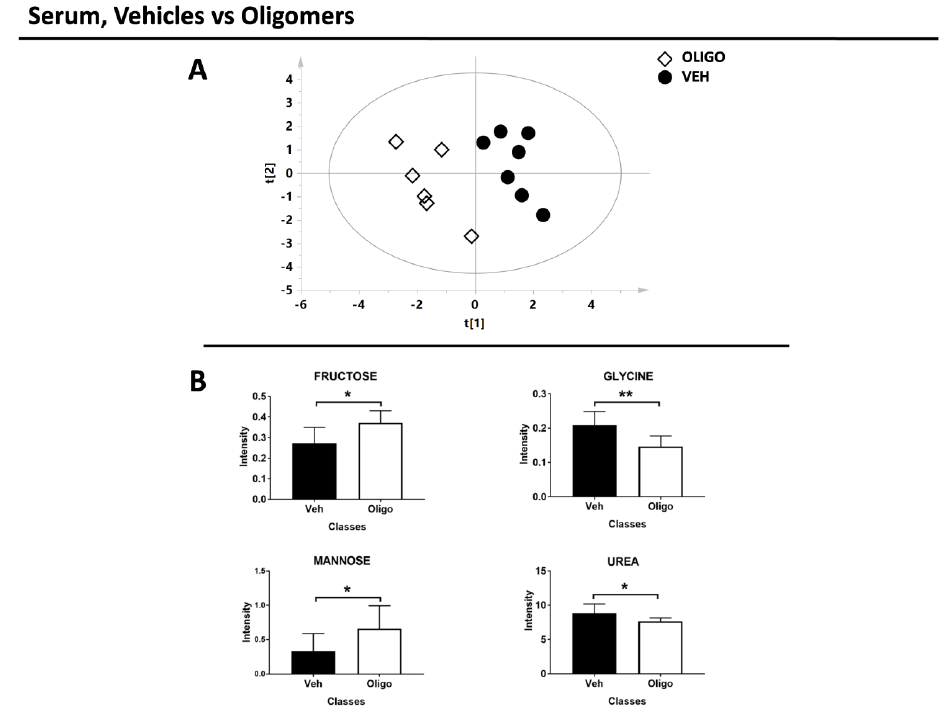
Figure 6. Results of the multivariate and univariate analyses of the serum sample. ( A ) Score plot of the rats infused with oligomers (white diamonds) and vehicles (black circles). ( B ) Bar graphs of the discriminant metabolites. U-Mann Whitney test was performed and these metabolites exhibit p -value < 0.05. * = p -value < 0.05; ** = p -value < 0.001